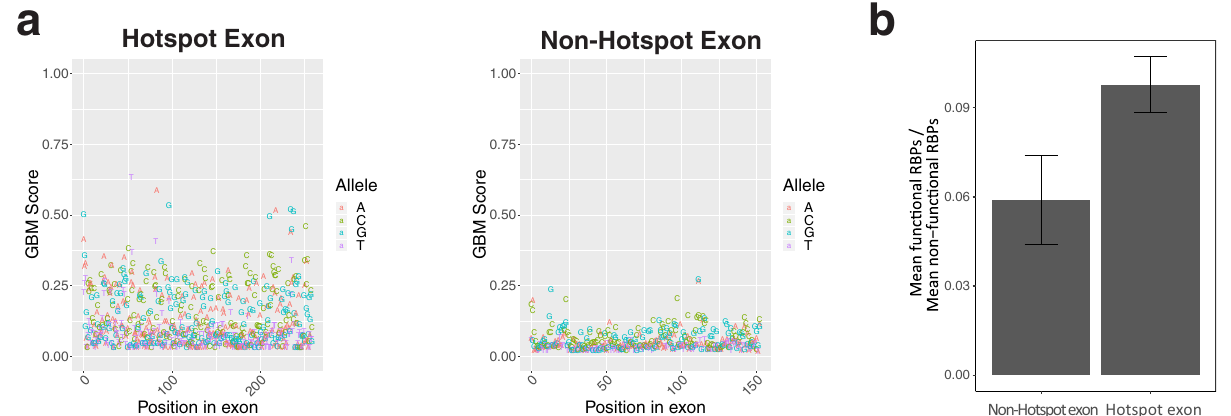
Fig. 7 GBM classi fi er determined hotspot exons. a GBM predictions are plotted for all possible variants in an example hotspot exon (left) and non-hotspot exon (right). Variants with a GBM score > 0.5 are classi fi ed as splice-disrupting variants. The x -axis represents the nucleotide position across the example exons. b Reanalysis of RBP binding between hotspot ( n = 1400 exons) and non-hotspot ( n = 102,600 exons) exons determined by the GBM classi fi er. Data are presented as mean